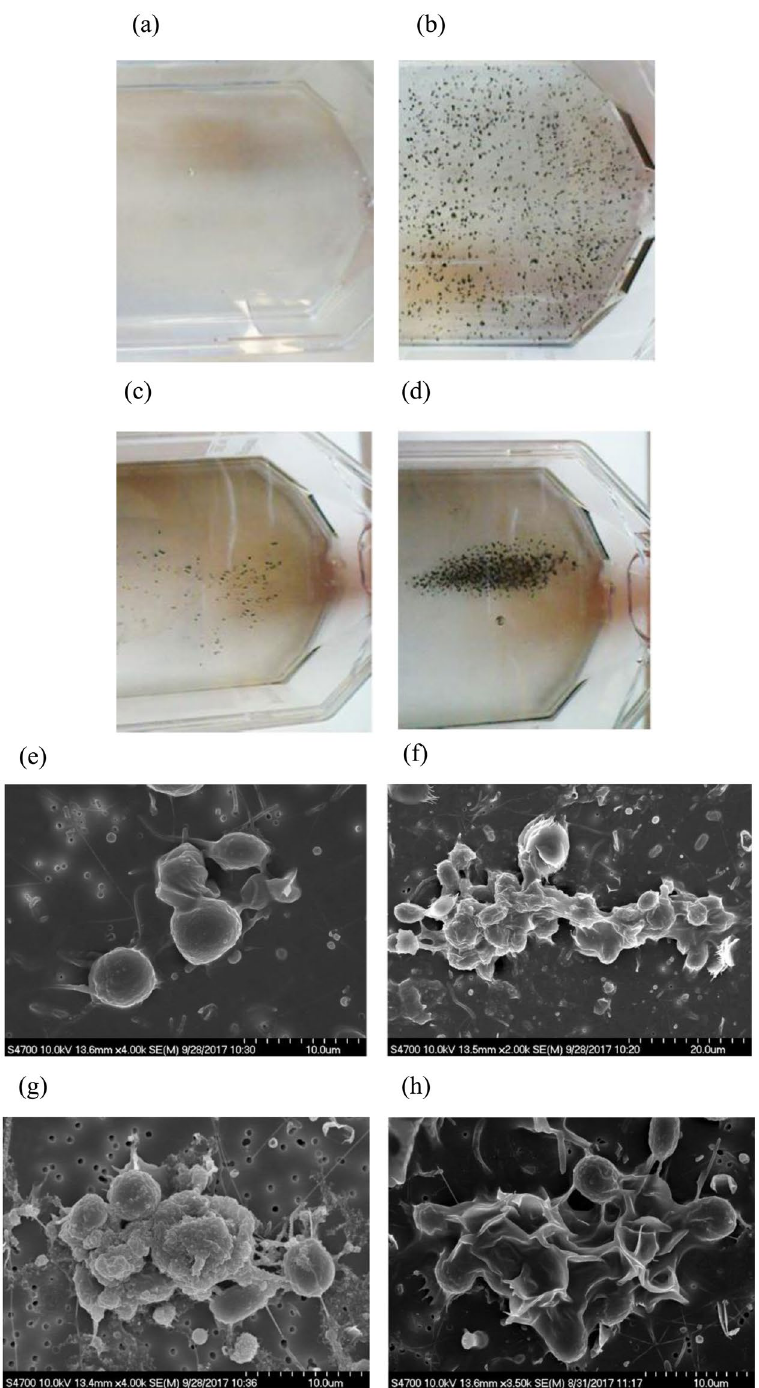
Figure 6. Macro-appearance of algae cultures indicating aggregate clumping of algae with CNT variants after 3 hours. ( a ) Control culture with algae alone. ( b ) Algae cultured with 25 µ g/mL CNT-COOH. ( c ) Algae cultured with 25 µ g/mL CNT-Ag. ( d ) Algae cultured with 25 µ g/mL CNT-Pt. Representative SEM images of algae interactions with CNT variants 3 hours post-exposure indicating particle/cell aggregation. ( e ) Control culture with algae alone. ( f ) Algae cultured with 25 µ g/mL CNT-COOH. ( g ) Algae cultured with 25 µ g/mL CNT-Ag. ( h ) Algae cultured with 25 µ g/mL